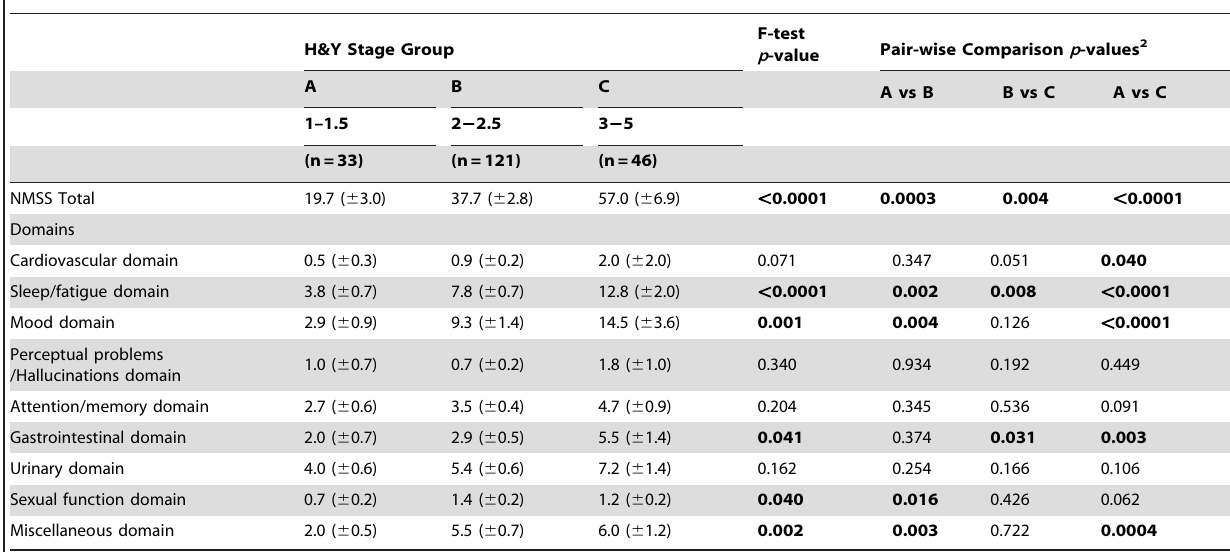
Table 4. Comparisons of PD patient group estimated NMSS scores 1 by H&Y stage.